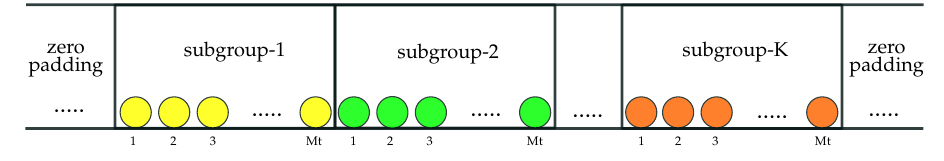
Figure 3. The subgroups in the frequency